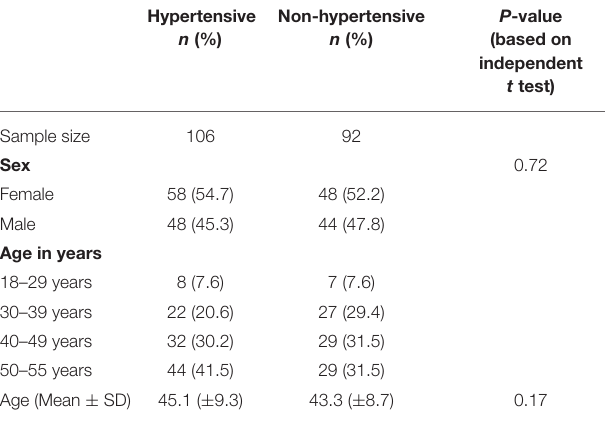
TABLE 1 | Demographic characteristics of study participants.